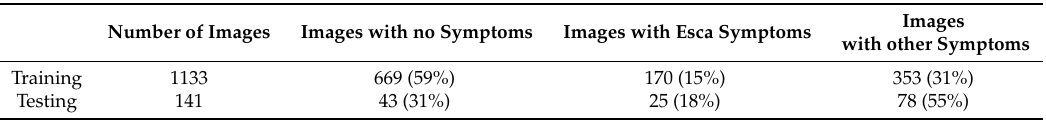
Table 6. Repartition of plants in the training and the testing database in the detection framework. Percentages do not necessarily add to 100% since some plants can have both esca symptoms and other